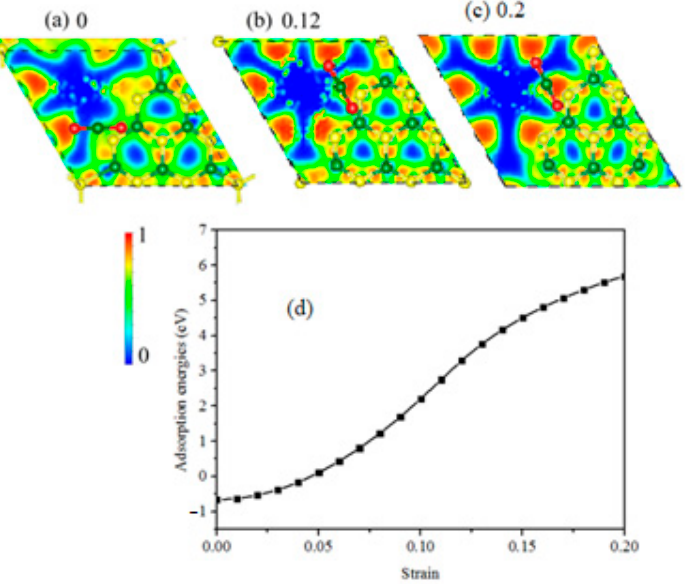
Figure 2. ( a ) the stress-strain curves of the CO 2 adsorbed g-C 3 N 4 system. ( b , c ) are the N–C bond length change-strain curves.